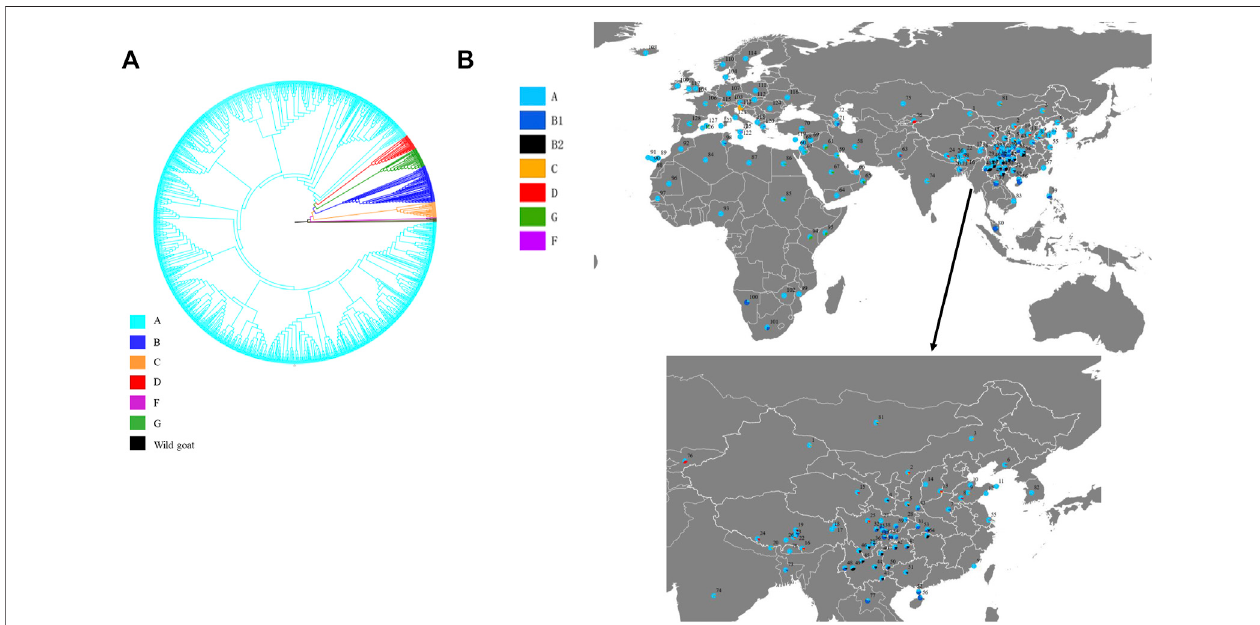
FIGURE 1 | Neighbor-joining trees of domestic goat based on 1,427 mtDNA haplotypes and on the 22 reference mtDNA haplotypes (A) and the geographic distribution of domestic goat mtDNA lineages (B) . Details of digit code are present in Supplementary Table S1 .